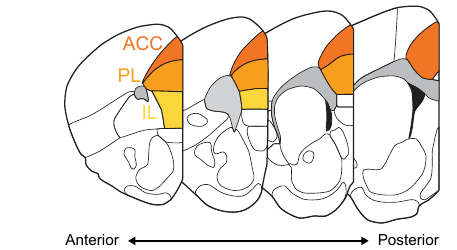
Box figure. Coronal sections of the mouse brain along the antero-posterior axis with the 3 major subdivions of the mPFC highlighted (Anterior cingulate cortex ACC, Prelimbic cortex PL, Infralimbic cortex IL) based on the Allen Brain Atlas.